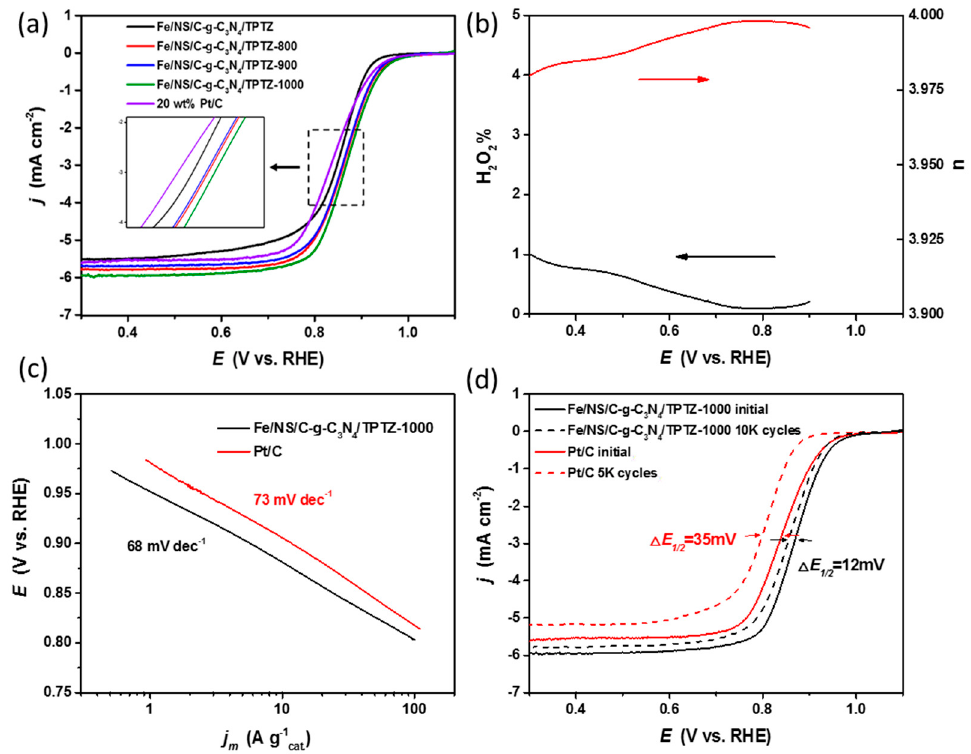
Figure 7. ( a ) ORR polarization curves of Fe/NS/C ‐ g ‐ C 3 N 4 /TPTZ, Fe/NS/C ‐ g ‐ C 3 N 4 /TPTZ ‐ T (T = 800, 900, 1000) and Pt/C catalyst in O 2 ‐ saturated 0.1 M KOH solution with a rotational speed of 1600 rpm and at a scan rate of 10 mV/s; ( b ) hydrogen peroxide yield and electron transfer number of Fe/NS/C ‐ g ‐ C 3 N 4 /TPTZ ‐ 1000 catalyst, ( c ) Tafel plots of Fe/NS/C ‐ g ‐ C 3 N 4 /TPTZ ‐ 1000 and Pt/C; and ( d ) ORR polarization curves of Fe/NS/C ‐ g ‐ C 3 N 4 /TPTZ ‐ 1000 (before and after 10,000 potential cycles) and Pt/C (before and after 5000 potential cycles).